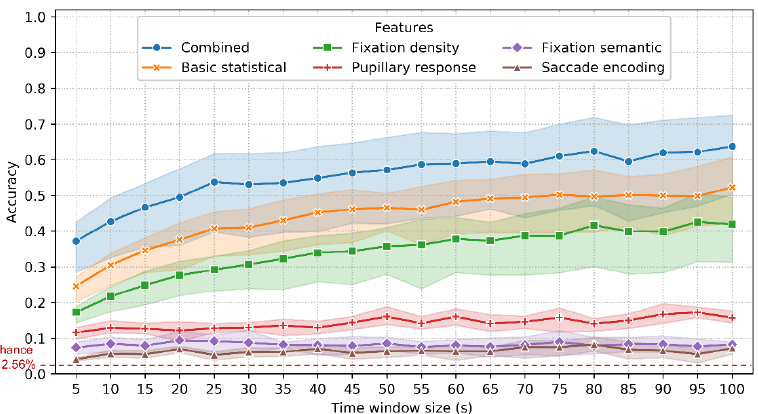
Figure 9. Accuracy and 95% CI with varying time window size and feature types using the LORO classification. Refer to Table A2 in Appendix A for detailed accuracy values.